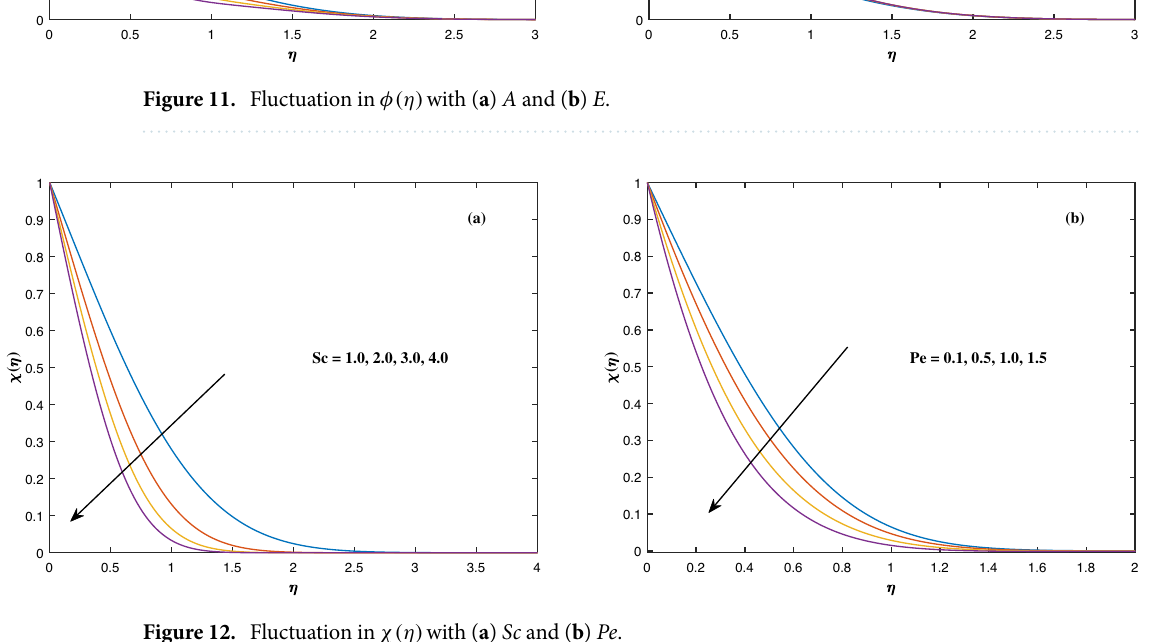
Figure 12. Fluctuation in χ(η) with ( a ) Sc and ( b ) Pe